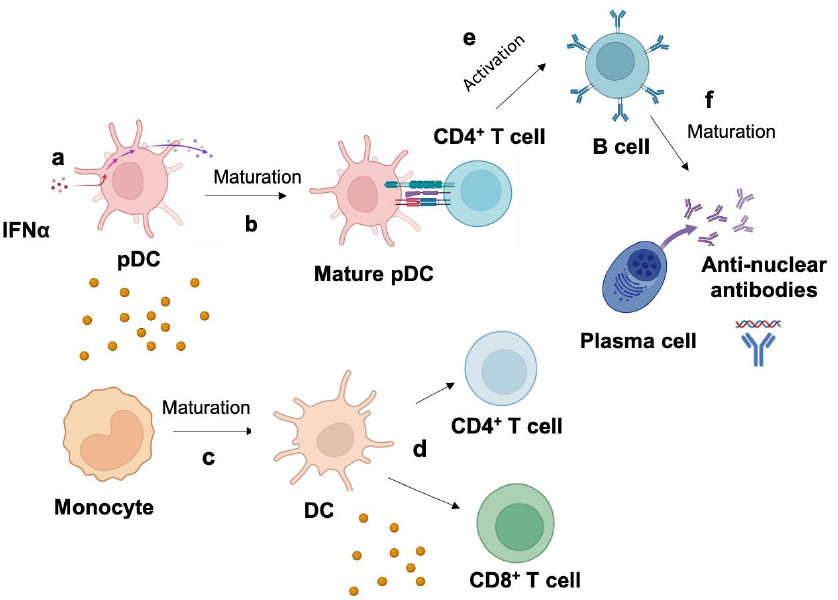
Figure 2. Mechanism of type I interferon signature in systemic lupus erythematosus (SLE) pathogenesis. ( a ) Plasmacytoid dendritic cells (pDCs) produce IFN α due to immune recognition of autoantigens derived from apoptotic material from dead and dying cells and neutrophil extracellular trap debris. ( b ) IFN α promotes the maturation of ( b ) pDC to mature pDC and ( c ) monocyte to dendritic cells (DC), which activates T cells. IFN α promotes ( d ) the exhaustion of CD8 + cells and ( e ) the activation of B cells after interacting with a CD4 + T cell. ( f ) B cell matures into plasma-cell-producing autoantibodies specific to nucleic-acid-containing autoantigens. High autoantibody production led to the loss of B cell tolerance in